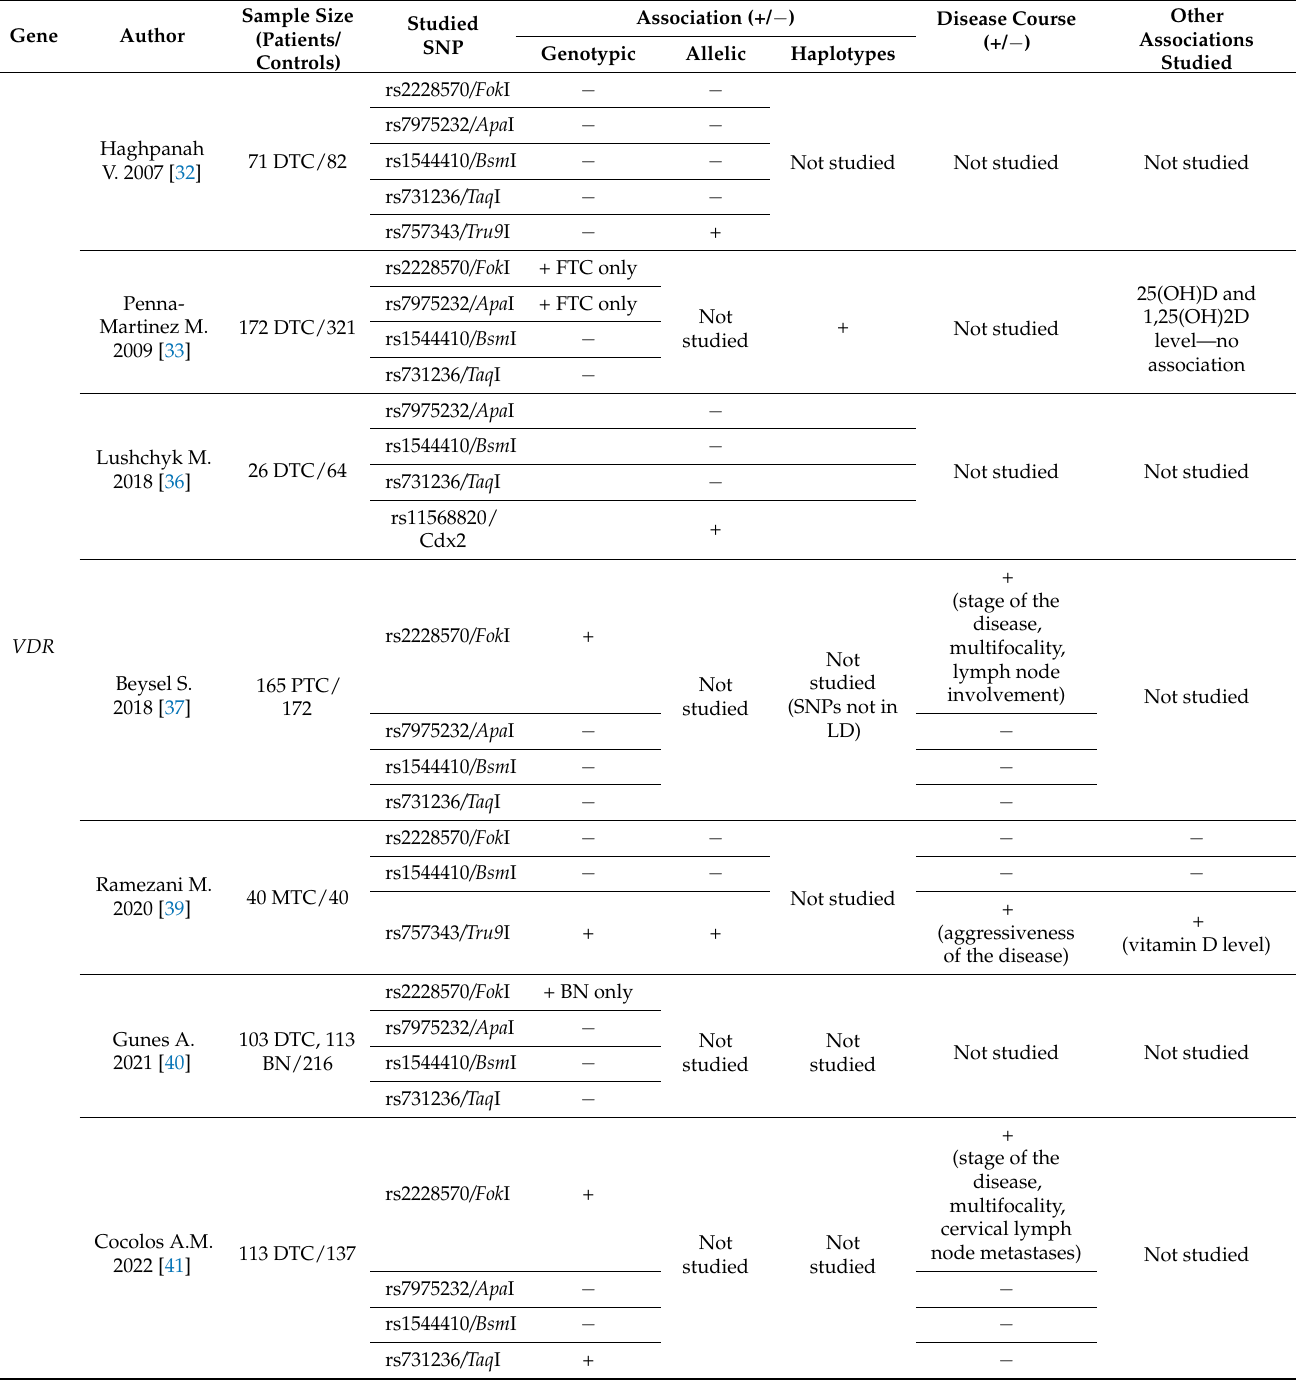
Table 2. Association between vitamin D-related gene polymorphisms and thyroid cancer—results of the